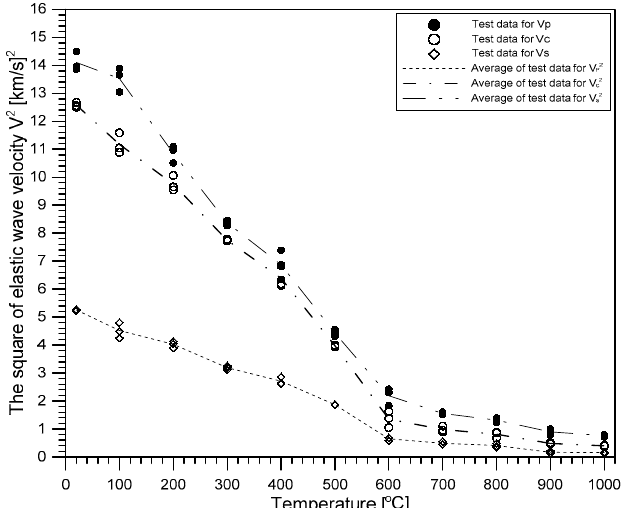
Figure 8. Variation of the square values of the three stress wave velocities (constrained compressive wave velocity, V P , unconstrained compressive wave velocity, V C and shear wave velocity, V S ) of heat damaged concrete with maximum exposed temperature.